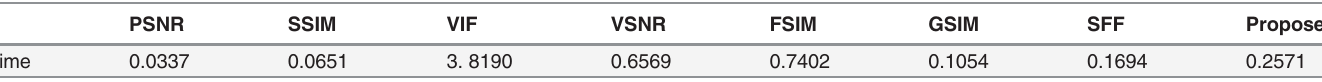
Table 5. Consuming time for IQA schemes (in seconds per image). PSNR